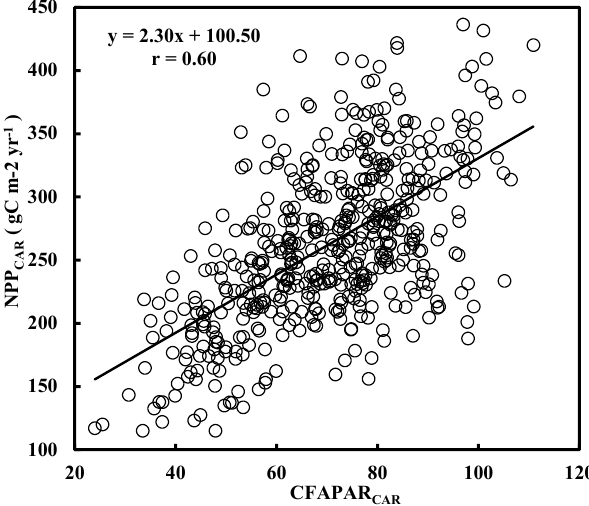
Figure 2 . Correlation between the cropland Net Primary Production at the CAR level (NPP CAR ) derived from crop (barely, wheat, canola and oats) yield reports of Statistics Canada and cumulative FAPAR at CAR level (CFAPAR CAR ).